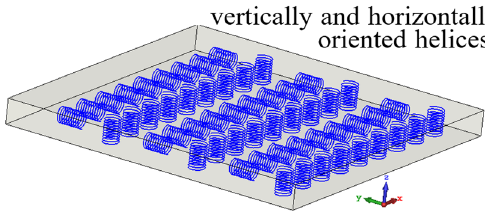
Figure 1. Bi-isotropic substrate 20 .